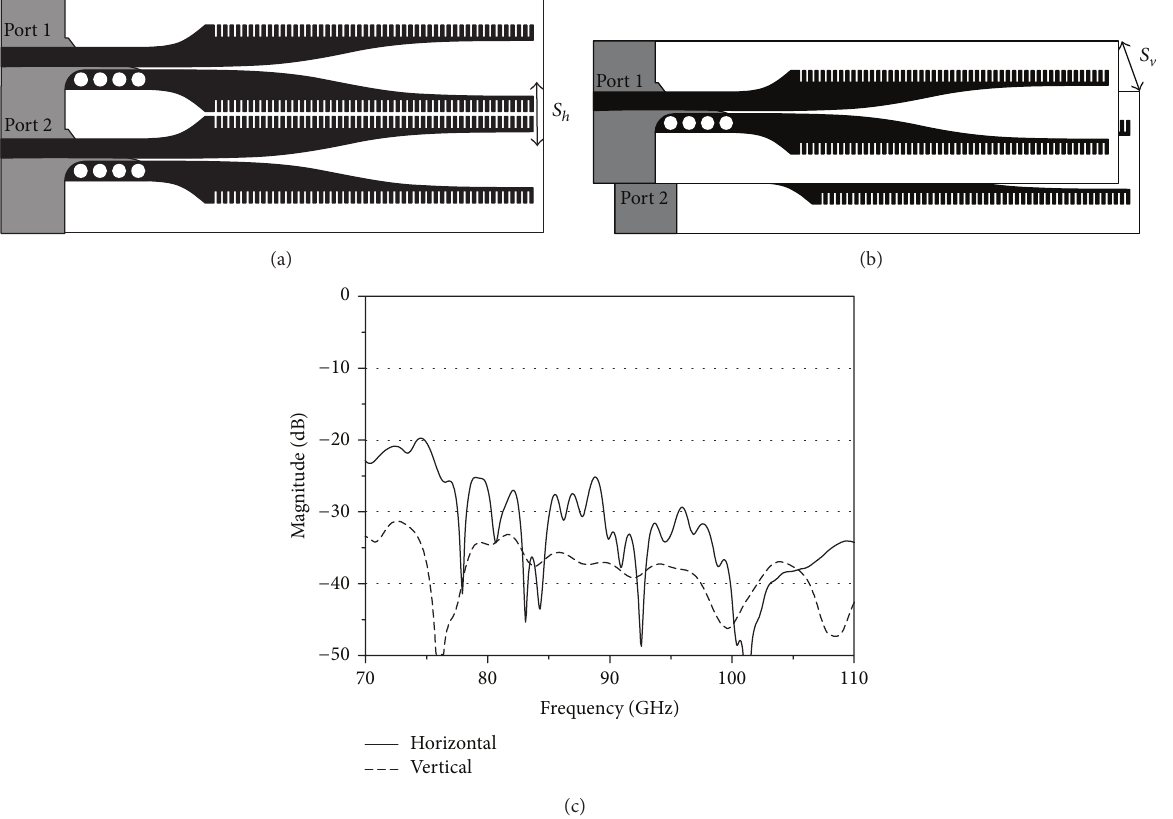
Figure 6: Two configurations of mutual couplings: (a) horizontal ( 𝑆 ℎ = 3.56 mm), (b) vertical ( 𝑆 V = 5 mm), and (c) simulated mutual couplings (𝑆 21 ) .